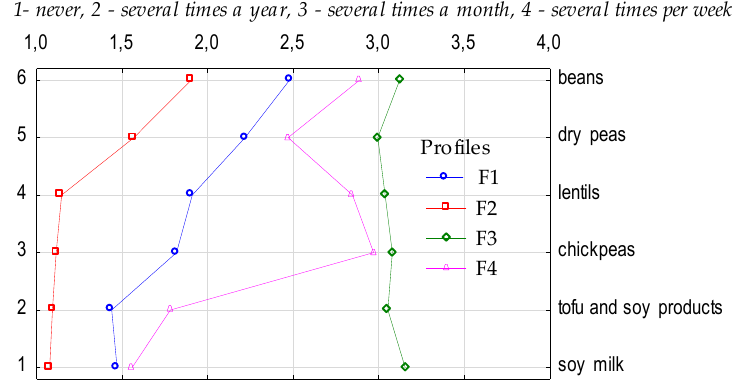
Figure 1. Profiles of respondents regarding frequency of pulse and soy product consumption.